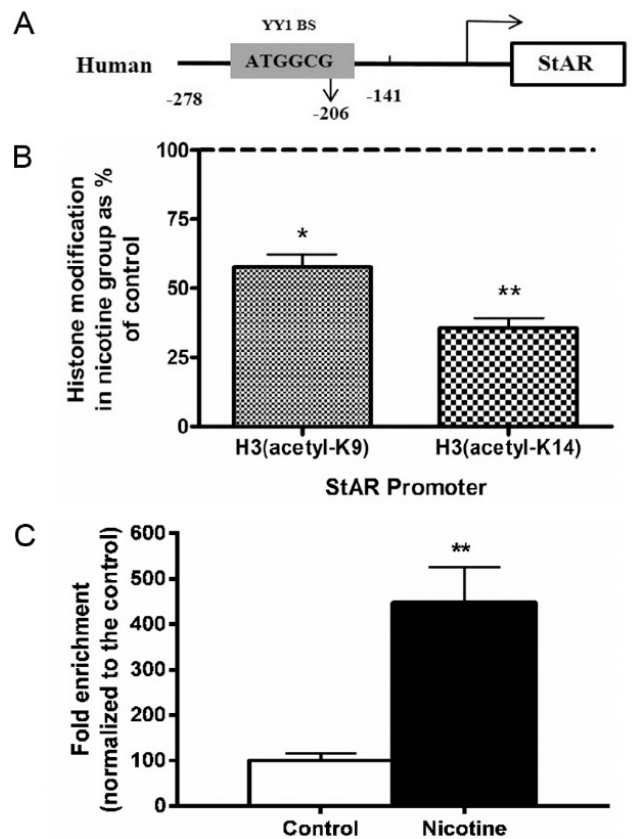
Figure 4. Effects of prenatal nicotine exposure on histone modification of the steroidogenesis acute regulatory protein (StAR) promoter and Yin Yang 1 (YY1)/steroidogenic acute regulatory (StAR) interaction in NCI-H295A cells. ( A ) Schematic of the human StAR promoter structure; ( B ) ChIP analysis for histone acetylation levels in StAR promoters; ( C ) ChIP analysis for the interaction between YY1 and StAR promoter. The NCI-H295A cells were treated with nicotine (50 μ M) for five days. After immunoprecipitating the complex with antibodies against acetyl histone H3K9, H3K14, IgG, or YY1, we detected the mRNA expression of StAR using qRT-PCR. Data are presented as the mean ± SEM, n = 3. * p < 0.05, ** p < 0.01 vs. control. Dashed line indicated the control group was 100%.